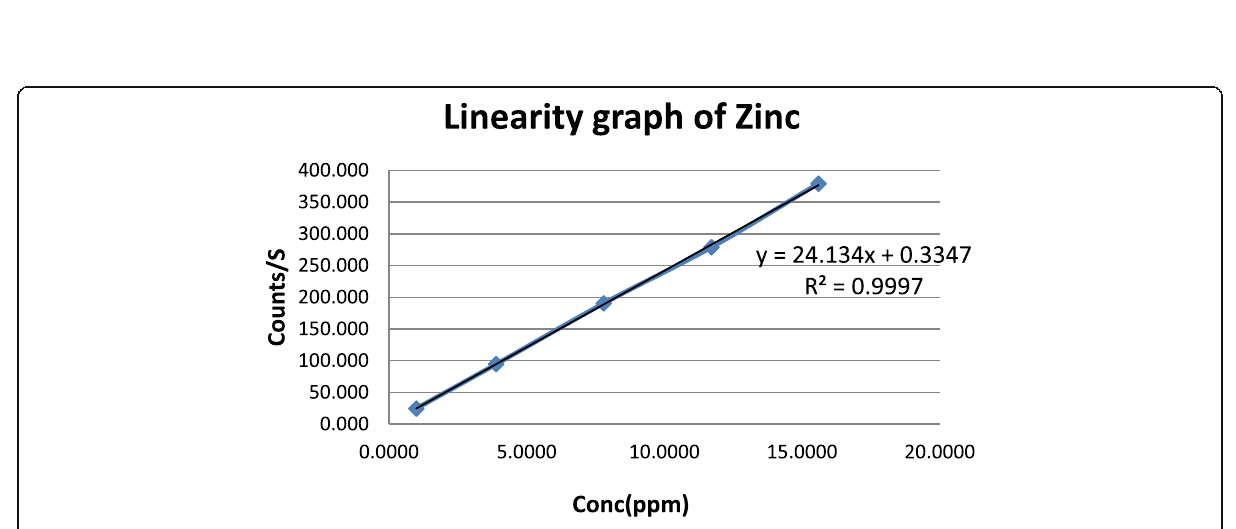
Fig. 4 Linearity graph of